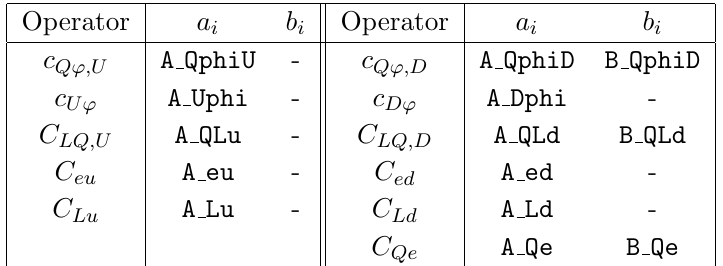
Table 5 . Notation for the coe(cid:14)cients of the di(cid:11)erent (cid:13)avor structures in the MFV framework, discussed in appendix B, which can be set in POWHEG